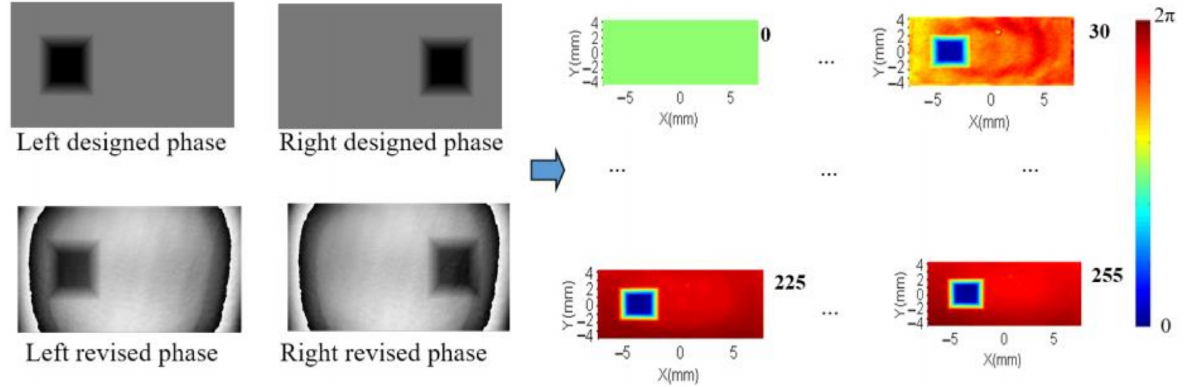
Figure 12. Process to get the global phase displacement with two series of phase maps.